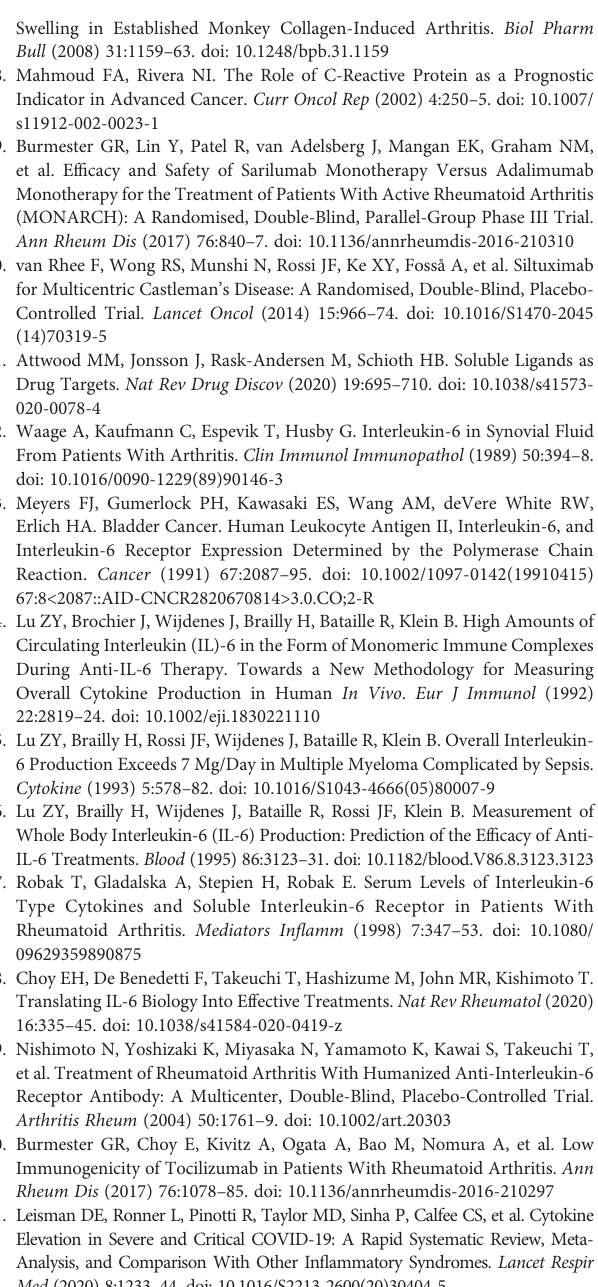
Supplementary Figure 2 | Immunoblot assay to determine the type of epitope for HZ-0408b. 30ug heat denatured rhIL-6-his was subjected to SDS-PAGE and HZ-0408b was used as primary antibody for immunoblot assay. Supplementary Figure 3 | Pharmacokinetic analysis of HZ-0408b in cynomolgus monkey. Both male (M) and female (F) cynomolgus monkeys were dosed with increasing amount of HZ-0408b (1mg/kg, and 5mg/kg). Blood was collected by venipuncture into tubes with no anticoagulant at indicated time points. Serum level of HZ-0408b was measure by ELISA as described in Methods using IL- 6 protein as coating reagent, followed by detection with an HRP-conjugated anti- human IgG